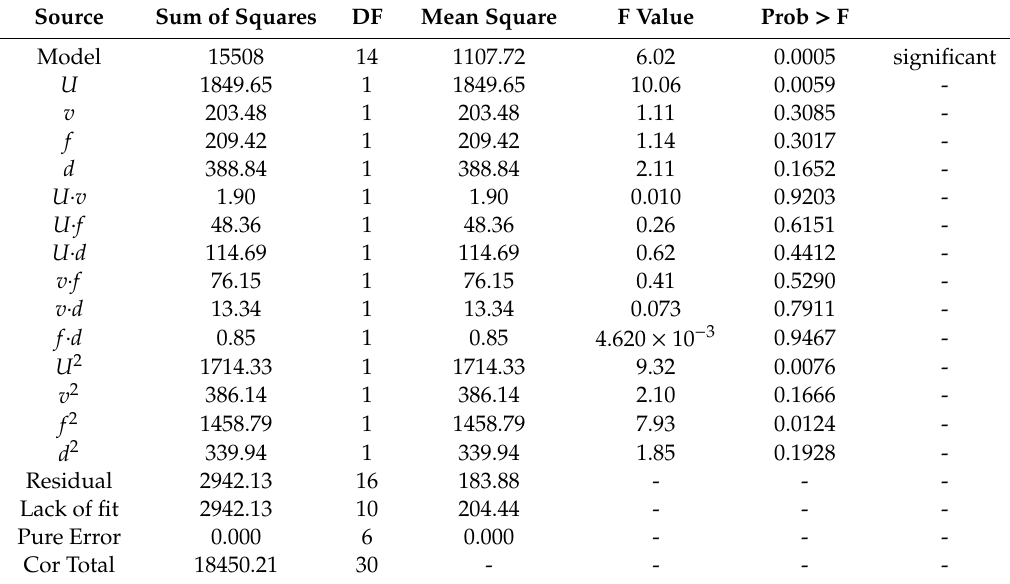
Table 5. Analysis of variance for R a